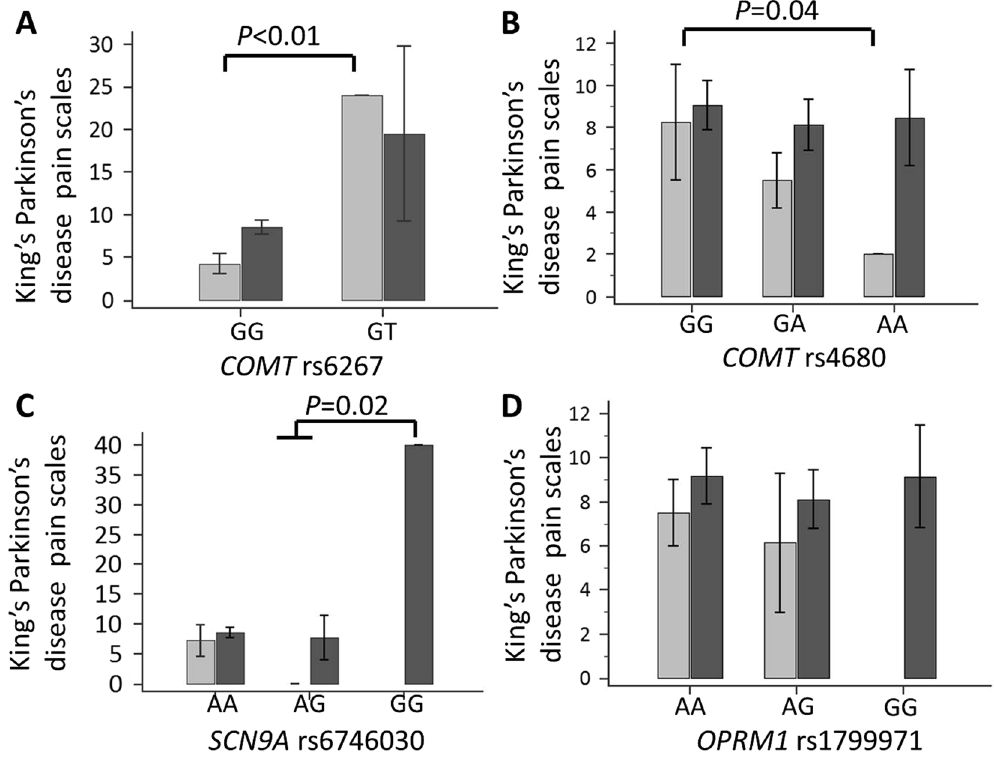
Figure 3. Mean KPPS scores of patients with different genotypes of COMT rs6267 ( A ), COMT rs4680 ( B ), SCN9A rs6746030 ( C ), and OPRM1 rs1799971 ( D ). PD patients having different genotypes were further subgrouped into those without depression (light gray color) and those with depression (dark gray color). Data are expressed as mean + SEM. * Represents P < 0.05 and ** represents P <